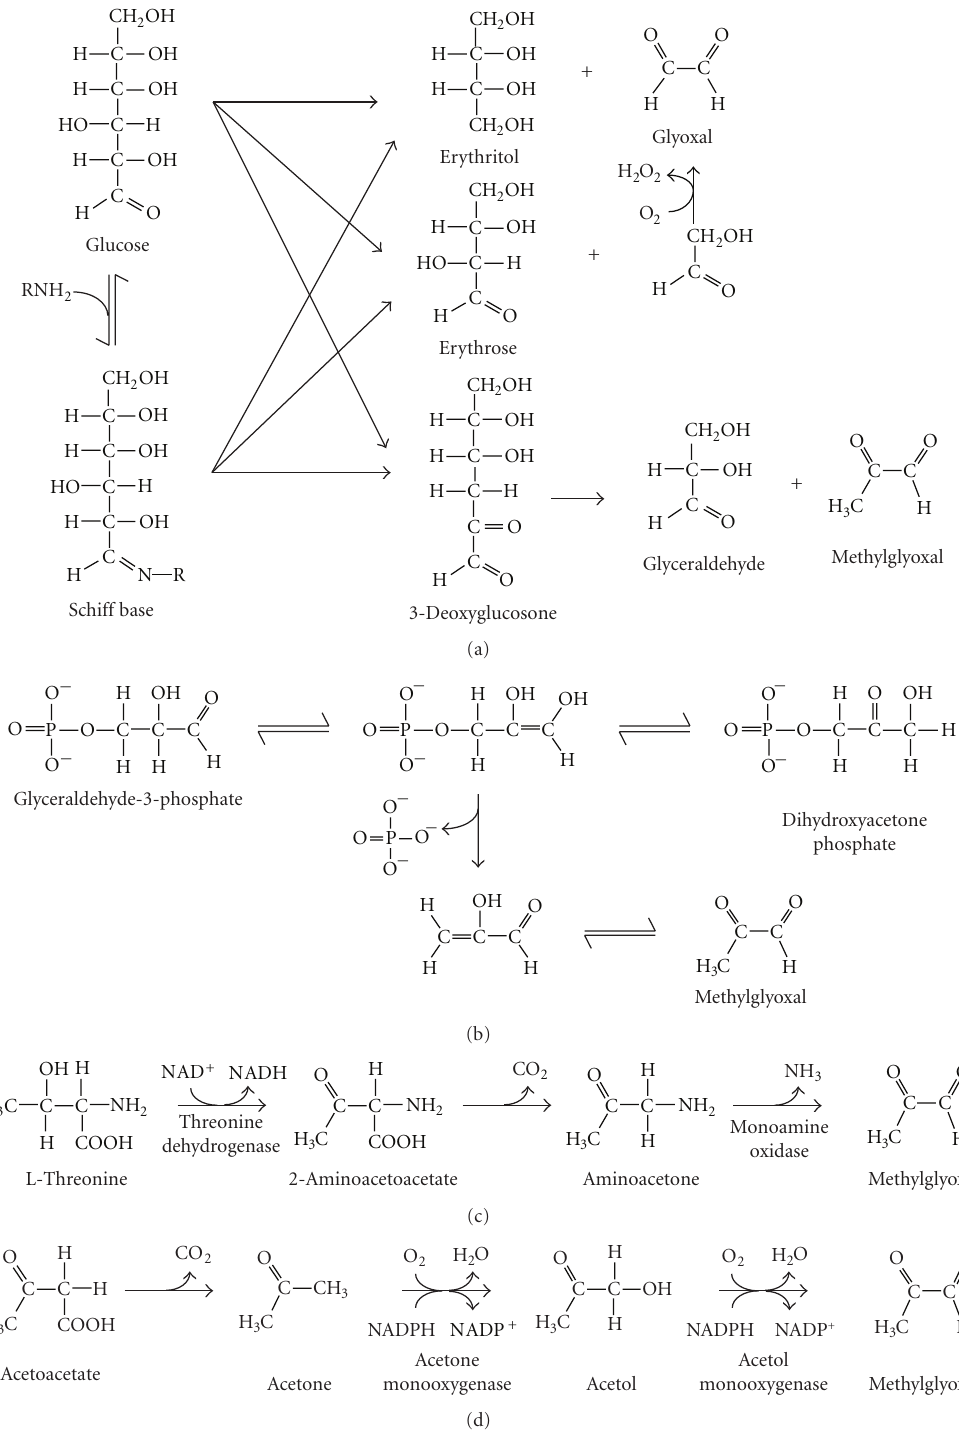
Figure 3: Formation of methylglyoxal and glyoxal in biological systems. (a) The acyclic form of glucose may undergo autooxidation via the Wol ff pathway to form glyoxal or break down to 3-deoxyglucosone which in turn degrades to glyceraldehyde and methylglyoxal. Glucose may also react with amine groups on proteins to form a Schi ff base which can undergo similar breakdown via the Namiki pathway to also generate glyoxal and methylglyoxal. (b) The major pathway by which methylglyoxal is formed in cells involves the breakdown of the triose phosphates, glyceraldehyde-3-phosphate, and dihydroxyacetone phosphate, via phosphate elimination from an ene-diol intermediate. (c) Methylglyoxal may also be generated during threonine catabolism. This involves oxidation of threonine by threonine dehydrogenase to 2-aminoacetoacetate, followed by spontaneous decarboxylation to aminoacetone. Monoamine oxidase then catalyses the conversion of aminoacetone to methylglyoxal. (d) Another pathway by which methylglyoxal is produced is from acetoacetate metabolism. This reaction proceeds via acetone and acetol and is catalysed by acetone monooxygenase and acetol